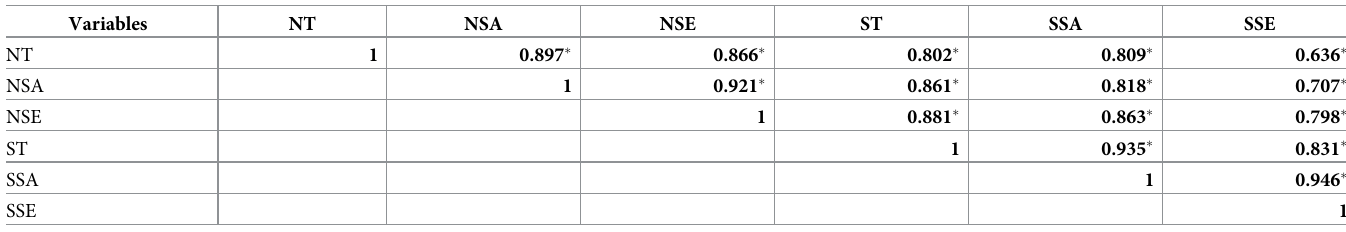
Table 8. Correlation matrix of floristic composition on the basis of frequency indicator at TLR site, Nanda Devi Biosphere Reserve, Western Himalaya.